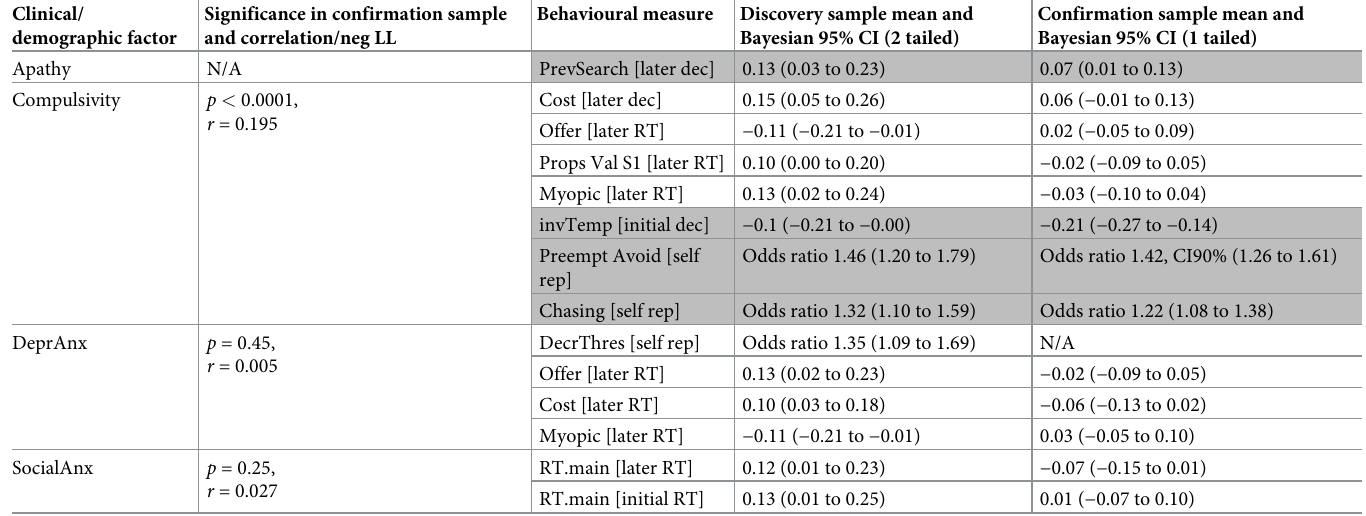
Table 3. Predicting transdiagnostic dimensions and demographics (confirmation sample). Clinical/ demographic